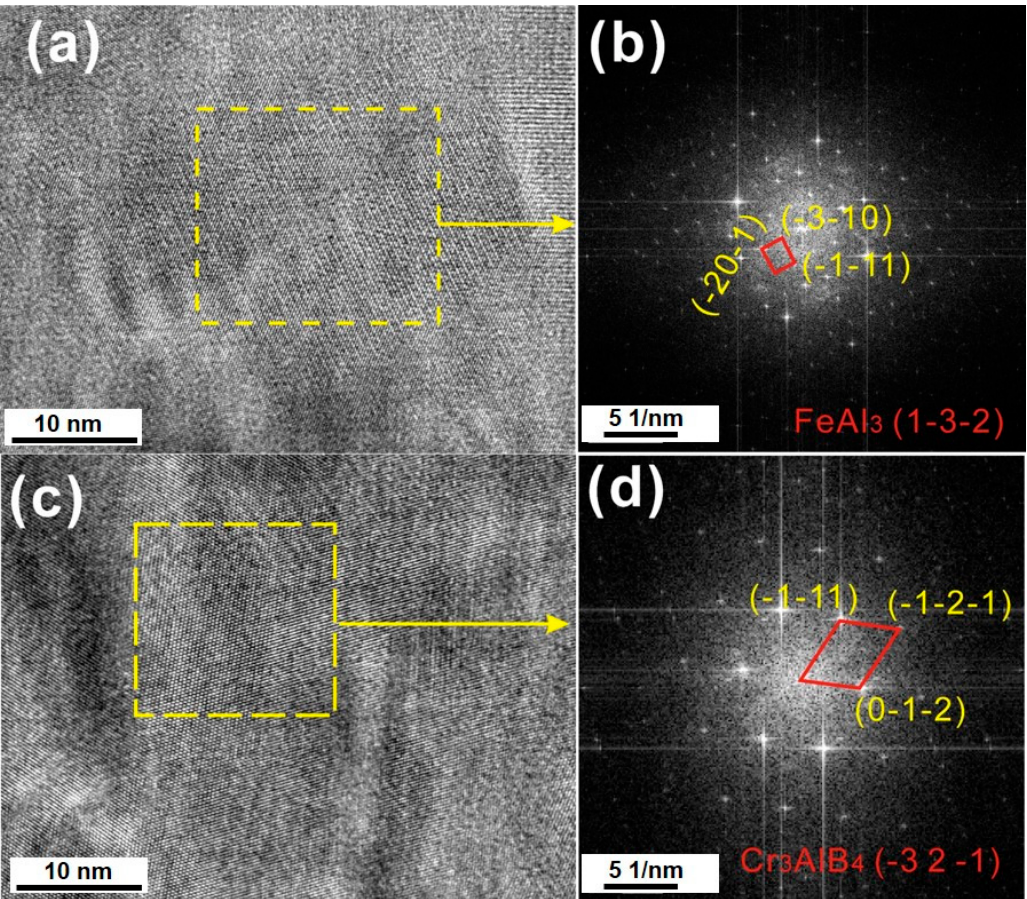
Figure 6. ( a ) and ( c ) The high resolution TEM (HRTEM) micrographs taken from the Cr-rich zone and the Cr-depleted zone within the Cr-rich band. ( b ) and ( d ) The fast Fourier transform (FFT) graphs correspond to ( a ) and ( c ), respectively.